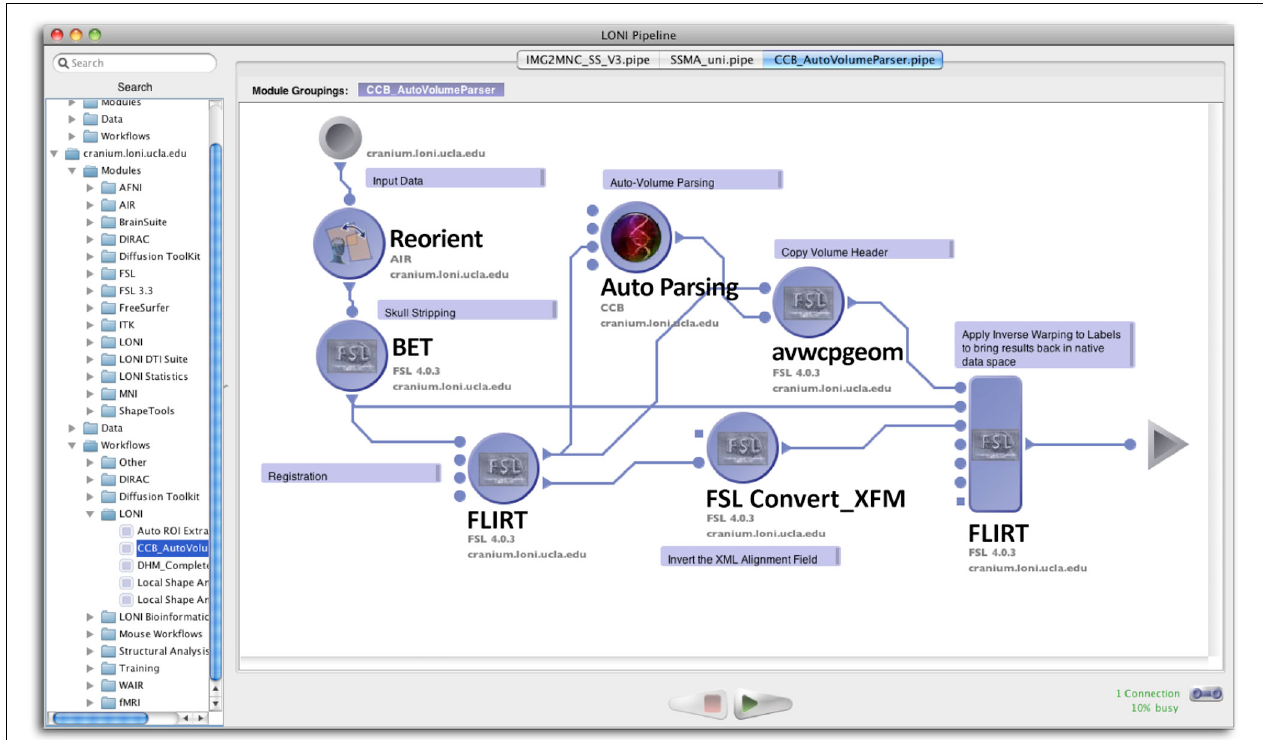
FIGURE 2 | The client interface to the LONI Pipeline execution environment.